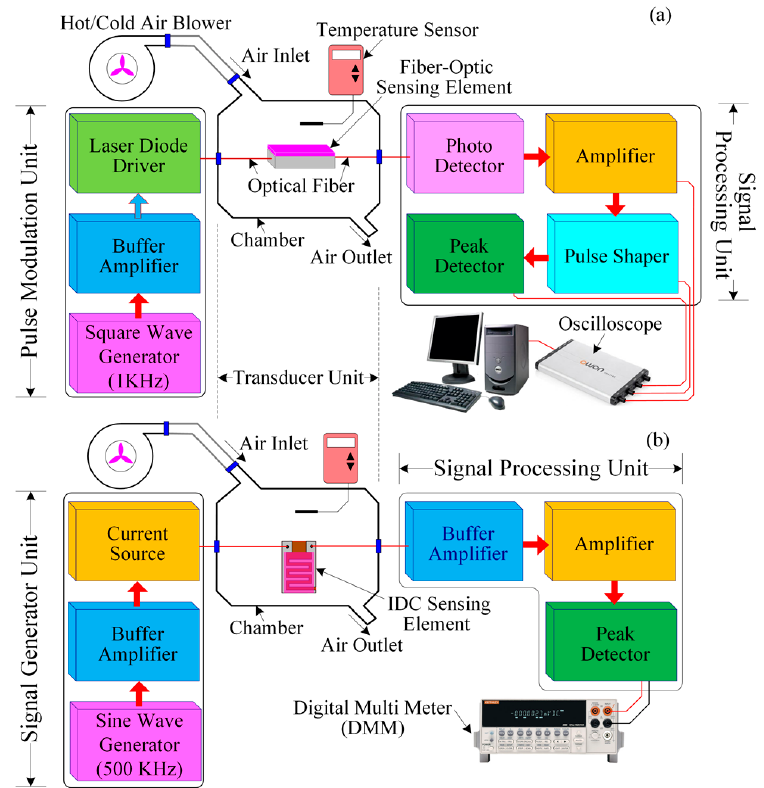
Figure 6. Schematic diagram of the experimental setup of the proposed temperature sensing system: ( a ) Fiber-optic PWM and ( b ) IDC. ( a ) Fiber-optic PWM and ( b )